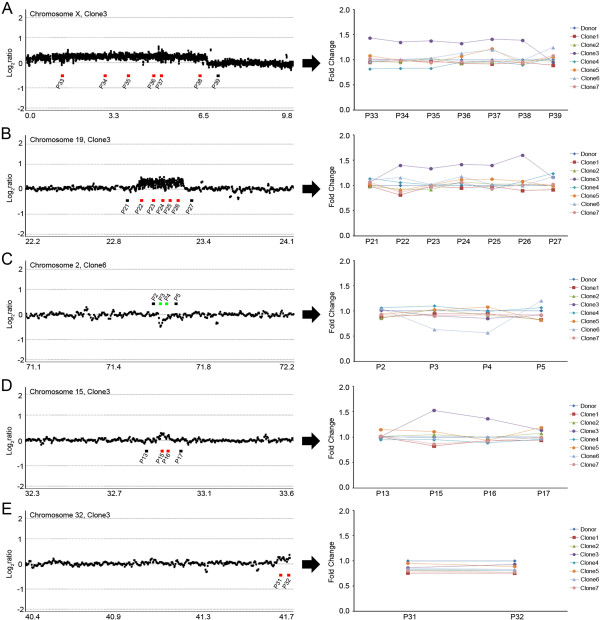
Multiple-point genomic qPCR validation. Left, Log2ratio plot on chromosome X (A), chromosome 19 (B), chromosome 15 (D), chromosome 32 (E) in clone 3 and chromosome 2 (C) in clone-6. Red and green bars represent primer position within the CNV-Gs and CNV-Ls, respectively. Black bars represent primer position outside the expected CNV breakpoint. The X-axis represents genomic position (Mb) and the Y-axis represents signal intensity ratio on a log2 scale. Right, multiple-point genomic qPCR validation. The Y-axis represents fold-change based on the nuclear donor as calibrator.